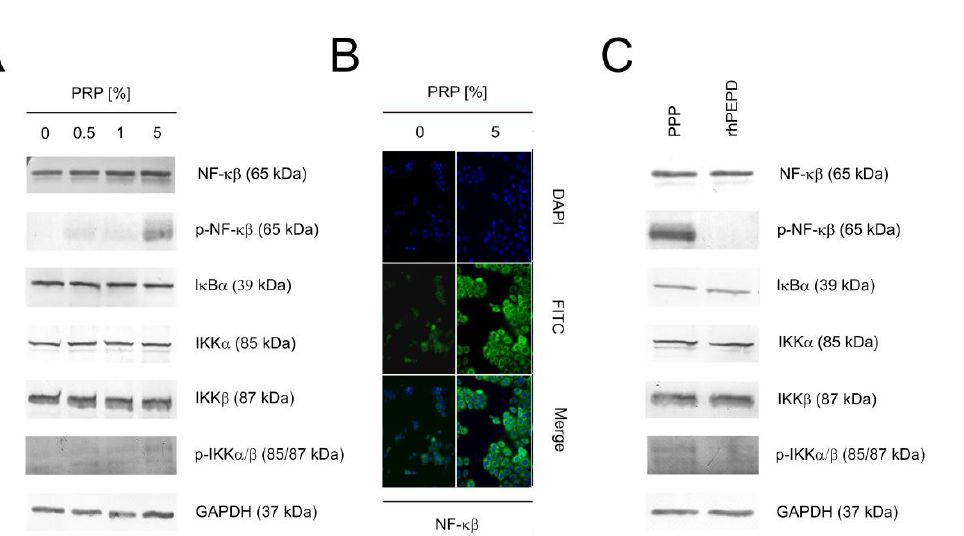
Figure 5. PRP induces activation of the NF- κβ signaling pathways in HaCaT cells. ( A ) PRP-dependent activation of NF- κβ signaling pathway; ( B ) Immunocytochemical staining of NF- κβ in PRP-treated keratinocytes. Magnification 200 × ; ( C ) Western immunoblotting of NF- κβ signaling in rhPEPD- and PPP-treated keratinocytes.